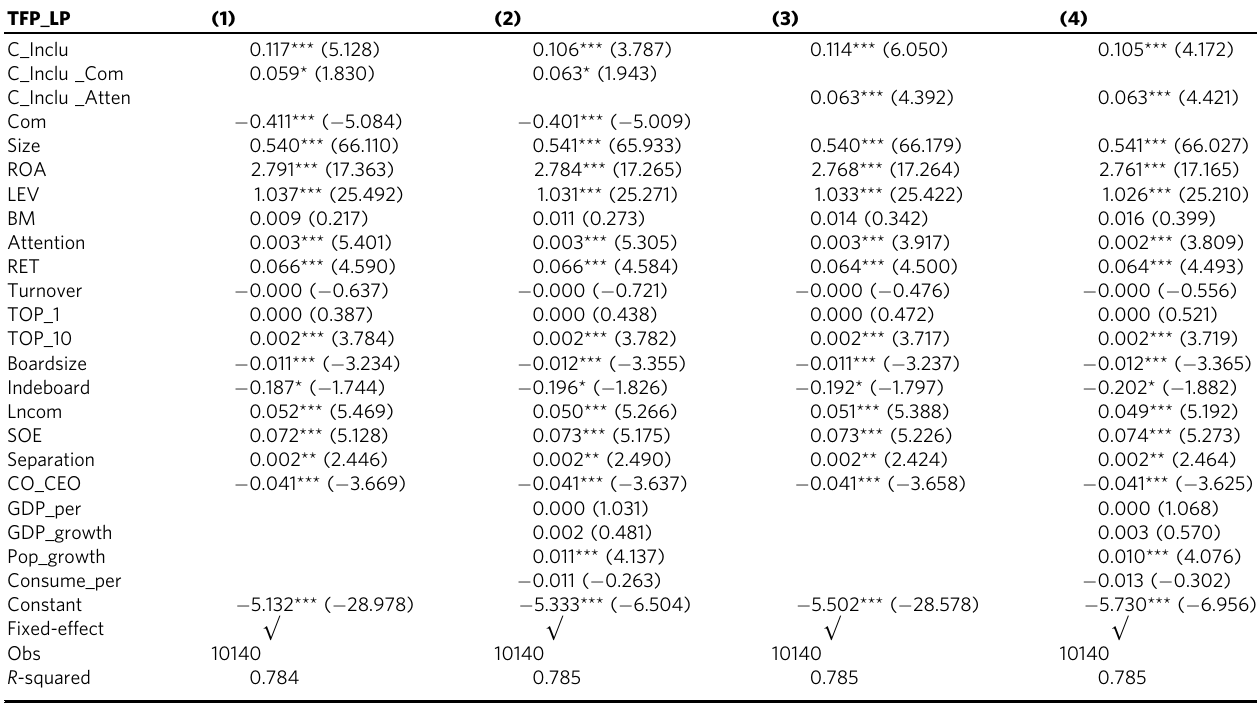
Table 10 The impact of cultural inclusion on corporate sustainability: cross-sectional